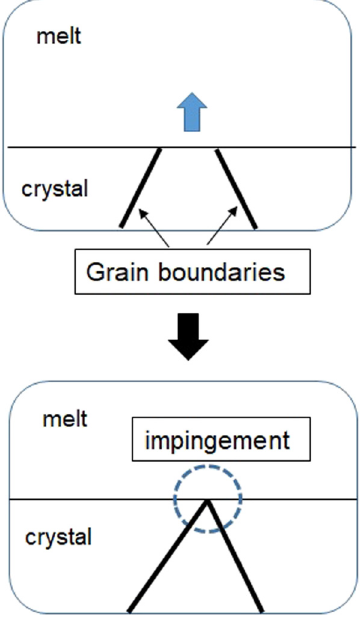
Figure 13: Schematic image of the impingement of two - grain boundaries at a crystal/melt interface.